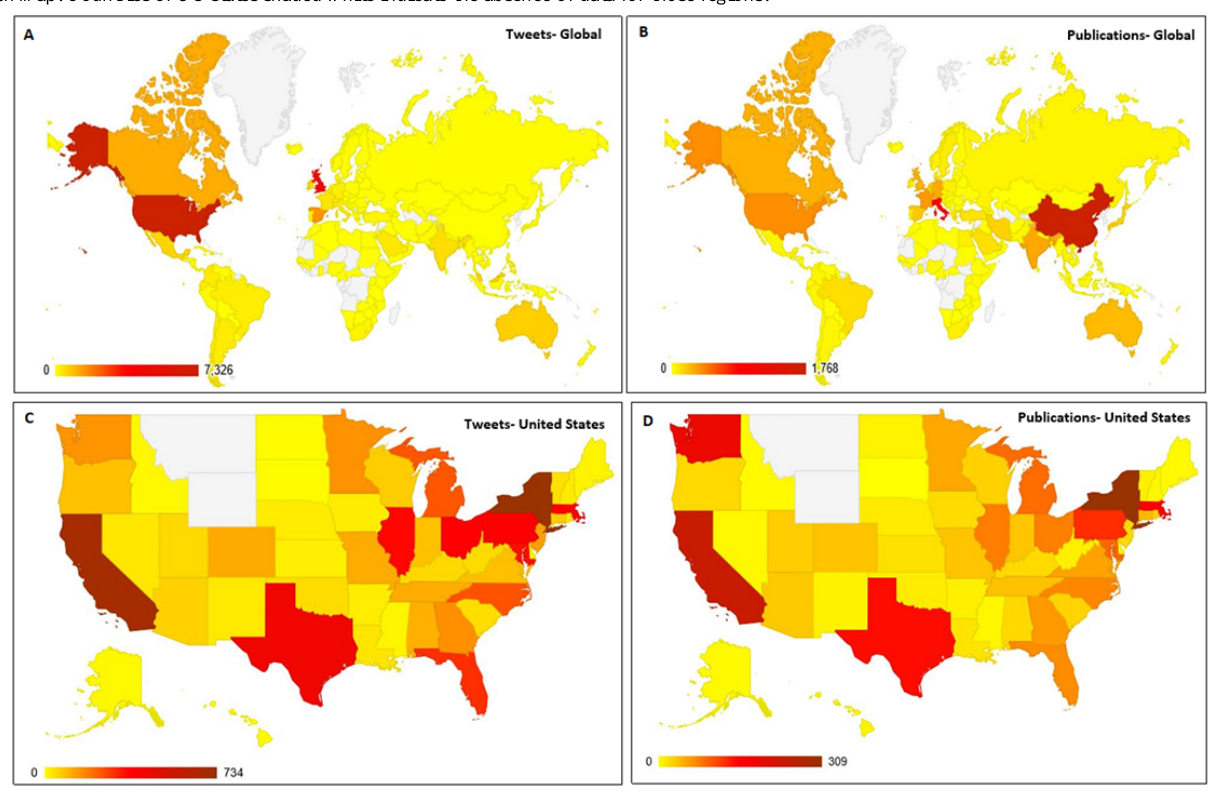
Figure 6. Heat maps illustrating the total number of COVID-19–related tweets (A) across the globe and (C) in the United States, as well as publications indexed in the PubMed-NCBI represented (B) across the globe and (D) in the United States, over the 6-month study period (December 2019 through May 2020). Numbers are represented on the spectrum from the least (yellow) to the highest amount (maroon), as detailed in the legend accompanying each map. Countries or US states shaded white indicate the absence of data for those